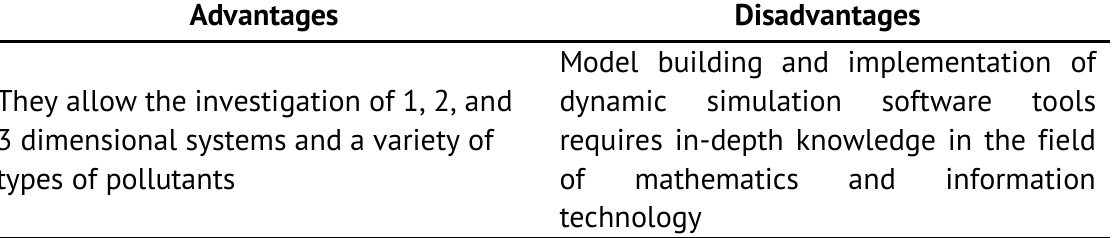
Advantages and disadvantages of dynamic simulation software